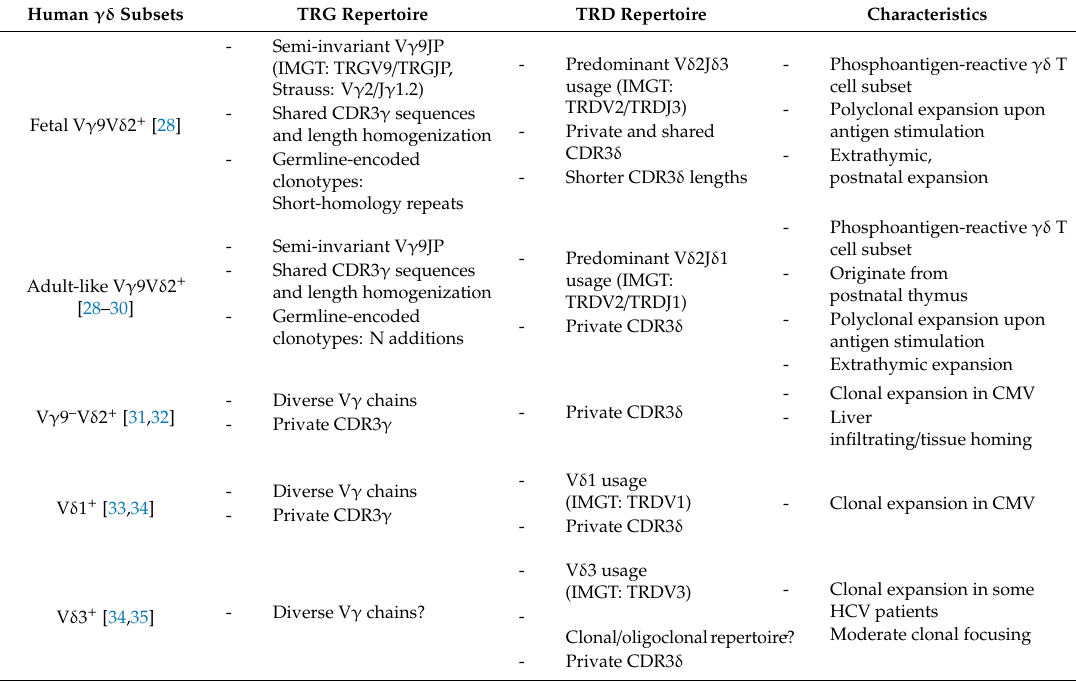
Table 1. Human γδ T cell subsets by high-throughput TCR sequencing. Table summarizes features of γ -chain (TRG) and δ -chain (TRD) repertoires of the major V γ 9V δ 2 + (fetal and adult-like)